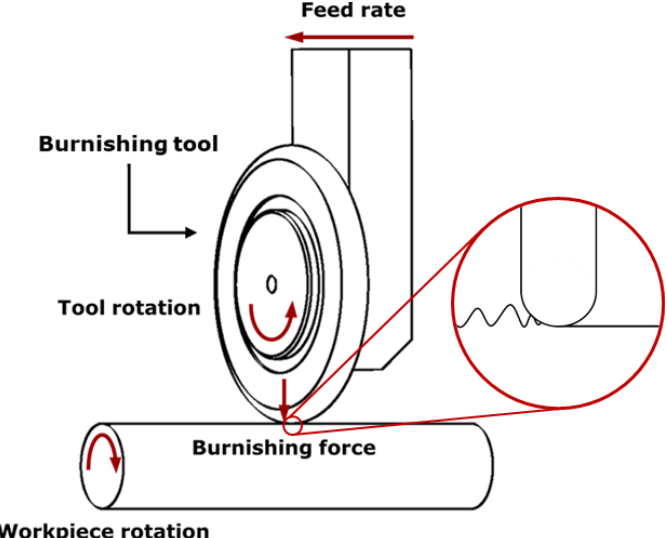
Figure 3. Scheme of roller burnishing process (Sanguedolce et al,